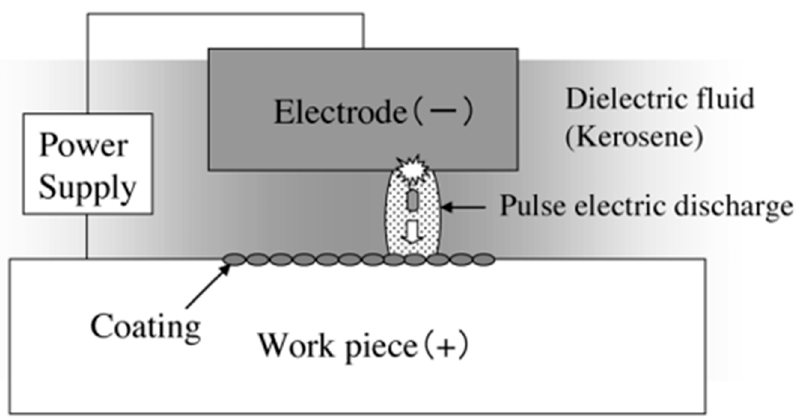
Figure 16. Schematic diagram representing the mechanism of the EDC process [112]. (With kind permission from Elsevier).